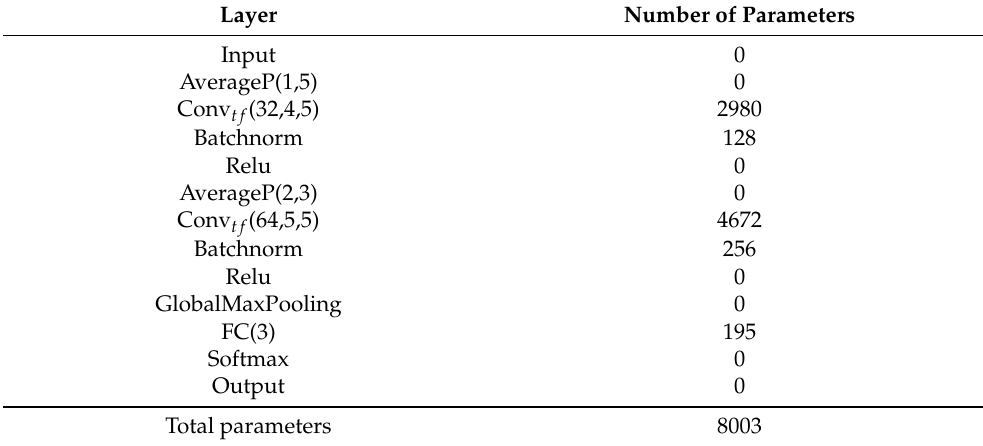
Table 2. Summary of the proposed network in term of connection configurations and number of parameters. Layer